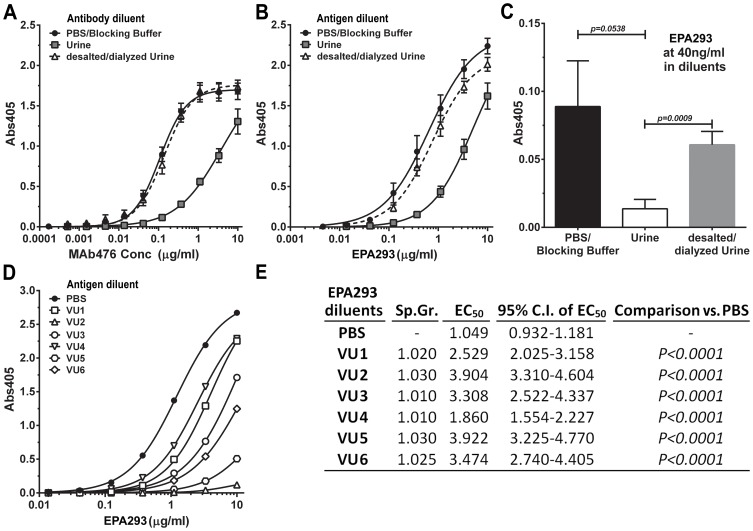
Urine has an inhibitory effect on MAb476-based immunoassays, which is abrogated by desalting or dialysis.
A, Comparison amongst PBS/blocking buffer, urine and desalted/dialyzed urine as a diluent for the secondary antibody in indirect ELISA. Antibody concentration to reach half maximal signal (EC50) in urine is significantly different than in PBS/blocking buffer or in desalted/dialyzed urine (p<0.001, F-test; data combined 3–9 independent assays). B,C, Comparison of PBS or blocking buffer vs. urine or desalted/dialyzed urine as a diluent for the EPA293 in sELISA. Panel B: Antigen concentration to reach half maximal signal (EC50) in urine is significantly different than in PBS/blocking buffer or in desalted/dialyzed urine (p<0.001, F-test; data combined 9–15 independent assays). Panel C: Comparison of mean signals at 40 ng/ml of EPA293 (urine vs. PBS/Blocking buffer and desalted/dialyzed urine, p = 0.0538 and 0.0009, respectively, unpaired t-test; N = 7–11 independent assays). D,E, Inhibitory effect of urine from 6 healthy volunteers in sELISA; EC50 values of all urines were significantly different from that of PBS (p<0.0001, F-test).